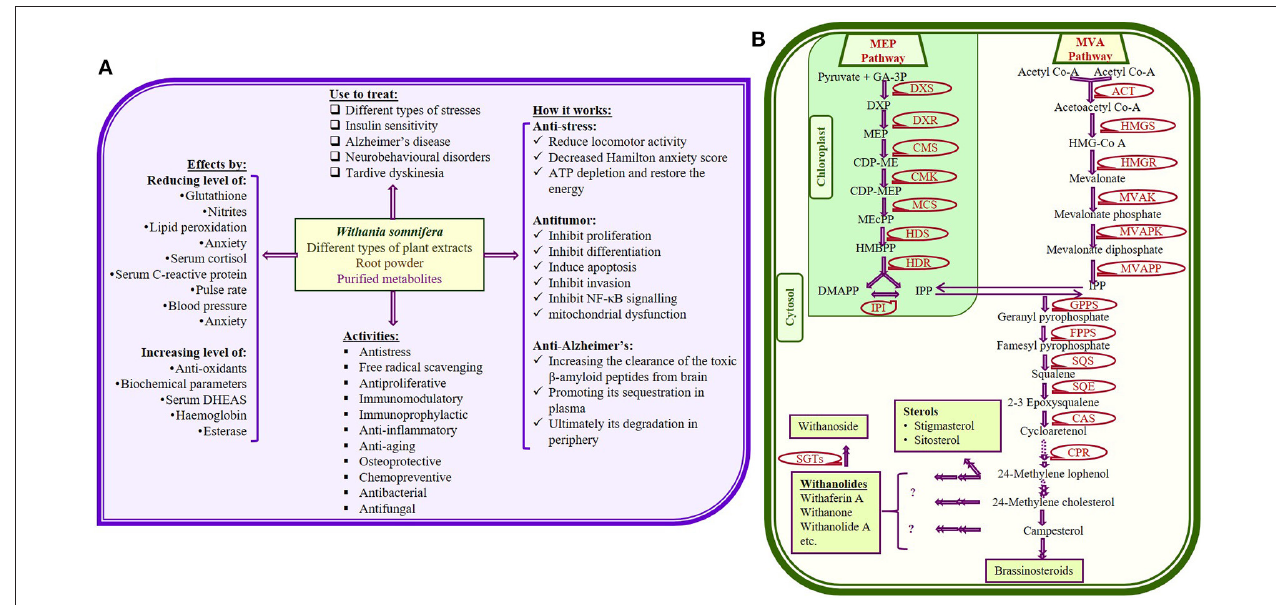
FIGURE 1 | (A) Some important therapeutic uses of Withania somnifera with few proposed mode of actions (Dar et al., 2015); (B) Possible metabolic pathway for withanolides and glycowithanolides (withanosides) production ( Senthil et al., 2010; Dhar et al., 2013; Sabir et al., 2013; Singh et al., 2015b) [GA-3P, glyceraldehyde-3-phosphate; MEP, 2-methyl- D-erythritol 4-phosphate; DMAPP, dimethylalyl pyrophosphate; IPP, isopentenyl pyrophosphate; IPPI, isopentenyl diphosphate isomerise; HMG-CoA, 3-hydroxy-3-methylglutaryl-coenzyme A; DXP, 1-deoxy-D-xylulose 5-phosphate; MVAPK, mevalonate phosphate kinase; MVAPP, diphosphomevalonate decarboxylase; CDP-ME, 4-diphospho-cytidyl-2-methyl-D-erythritol; CMS, 4-(cytidine-5-diphospho)-2-C-tmethyl-Derythritol synthase; CMK, 4-(cytidine-5-diphospho)-2-C-methyl-D-erythritol kinase, CDP-MEP, 2-C-methyl- D-erythritol-2-phosphate; MCS, 2-C-methyl-D-erythritol-2,4-cyclodiphosphate synthase; HDS, Hydroxy methyl butenyl 4- diphosphate synthase; HMBPP, Hydroxy methyl butenyl 4-diphosphate; HDR, Hydroxy methyl butenyl 4-diphosphate